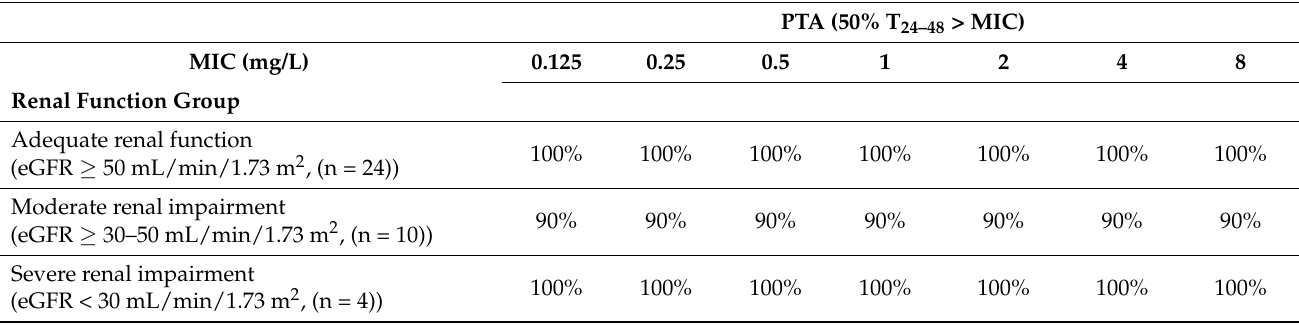
Table 6. Probability of PK/PD target attainment of 50% T > MIC for 24–48 h after the start of treatment based on the observed data in the different renal function groups using different MIC values of common Gram-negative bacteria susceptible to ceftazidime as listed in the